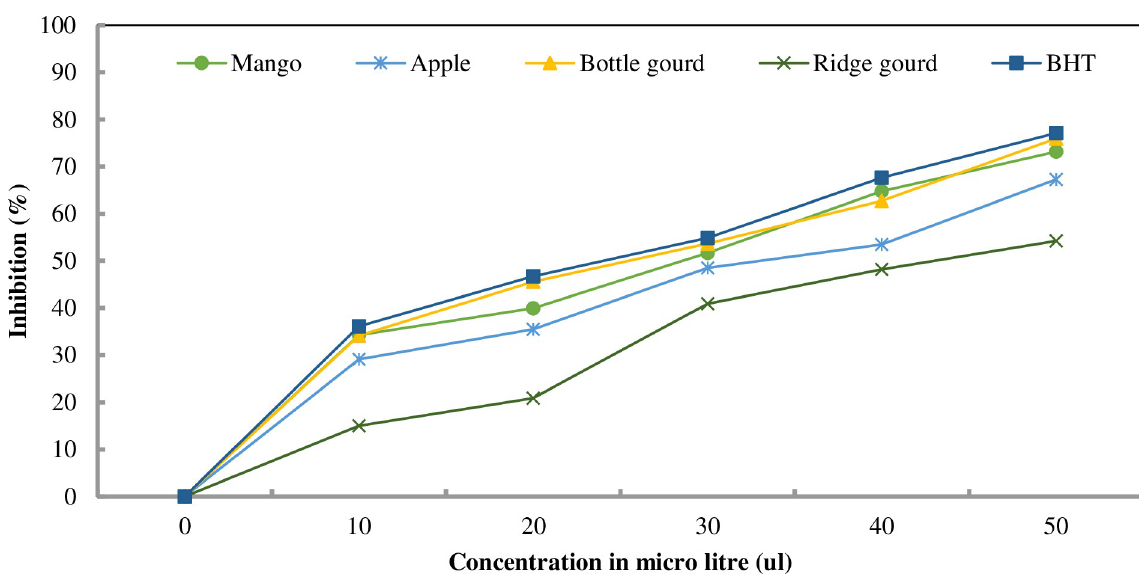
Fig 1. Percent inhibition of different fruit and vegetable